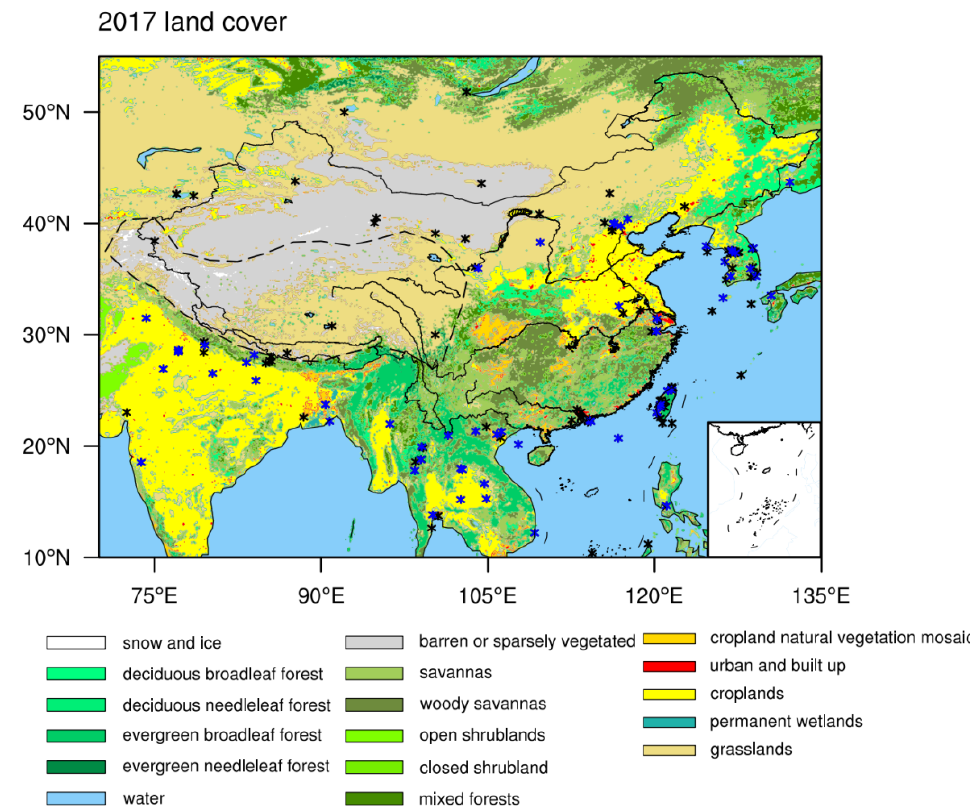
Figure 3. The distributions of land cover in East and South Asia in 2017. The asterisks represent the locations of AERONET sites with the blue asterisks indicating the 60 sites having enough valid data for analysis. The dash line is the contour of altitude of 3000 m.